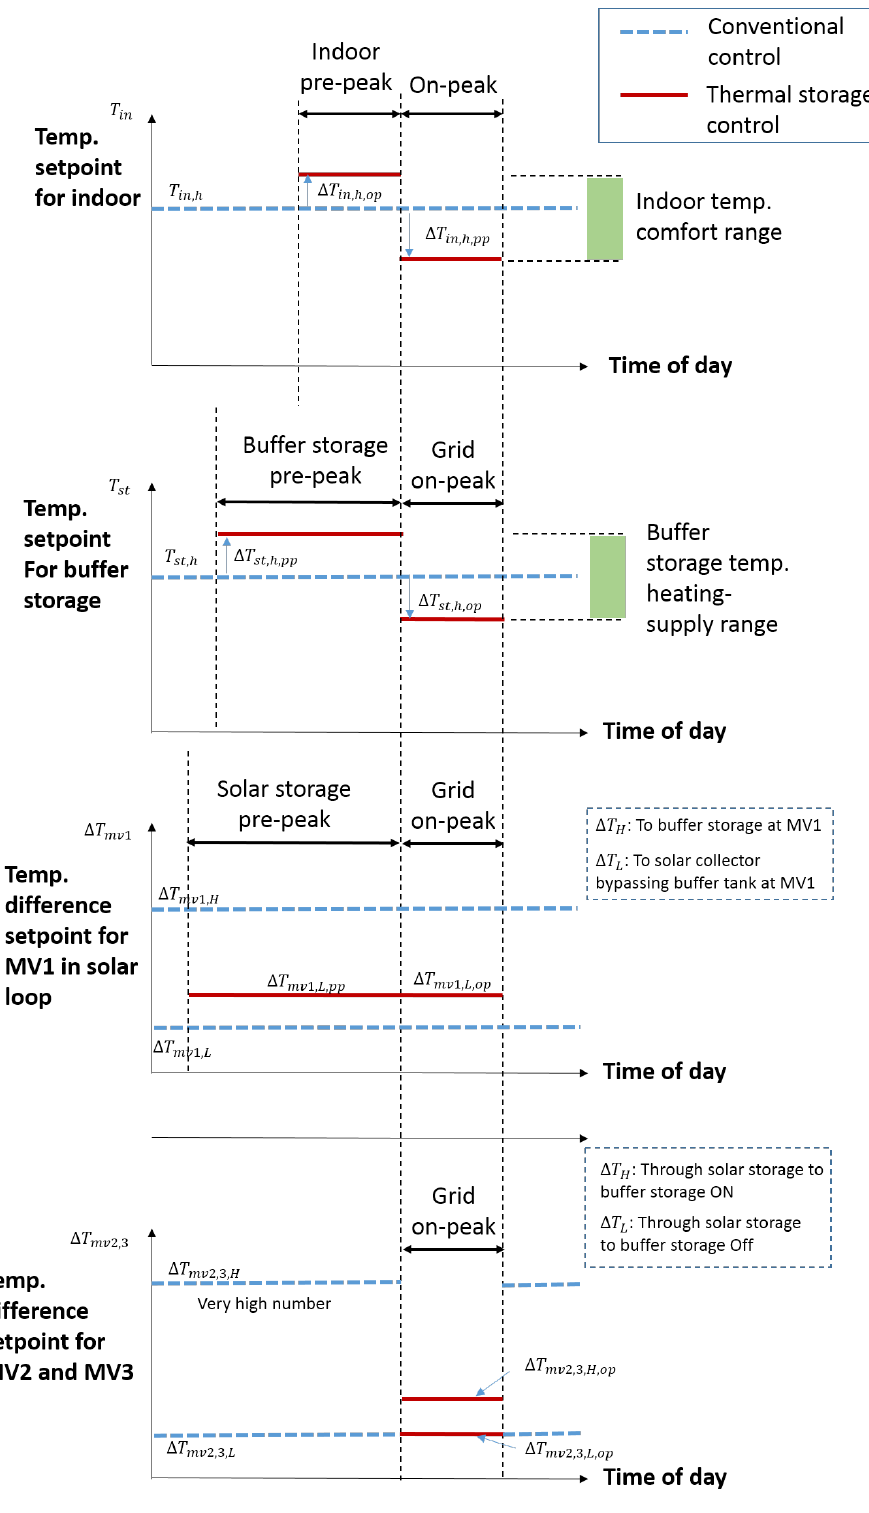
Figure 3. Schematic setpoint schedule for control strategies during heating